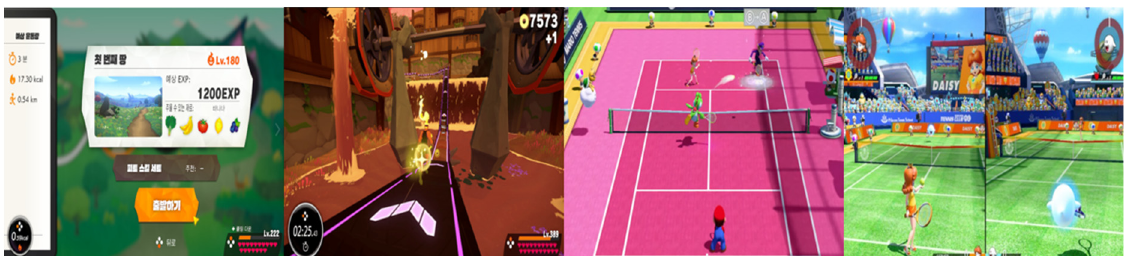
Figure 3. Nintendo Switch Ring Fit Adventure World 1 Beginnia, World 7 Starting-Block Bridge, Mario Tennis Aces Team Match, and Mario Tennis Single Match.